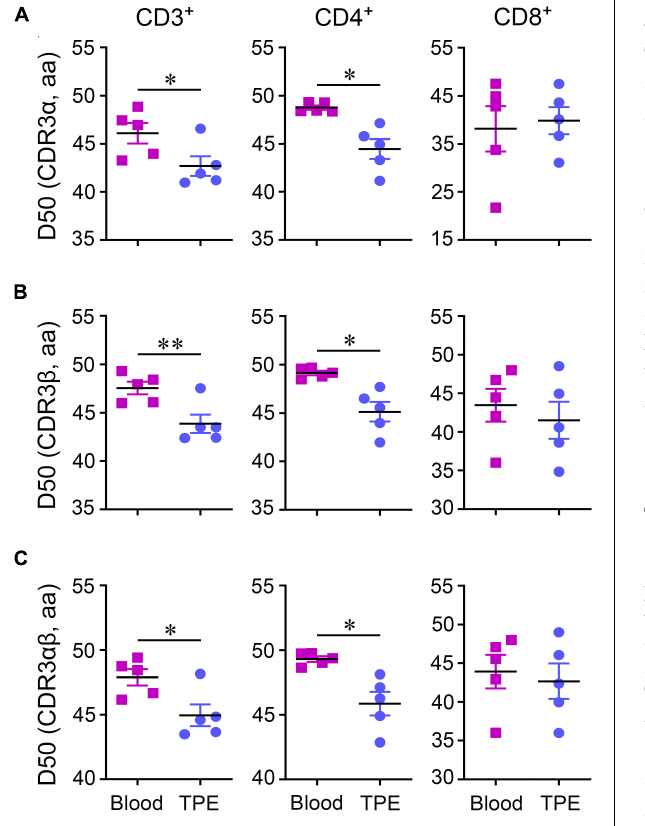
FIGURE 3 | Diversity 50 (D50) index of TCR repertoires in CD3 + , CD4 + , and CD8 + T cells between human TPE and blood. D50 index in CDR3 α (A) , CDR3 β (B) , and CDR3 αβ (C) . Data are presented as means ± SEM. ∗ P < 0.05, ∗∗ P < 0.01, determined by paired t test. TPE, tuberculous pleural